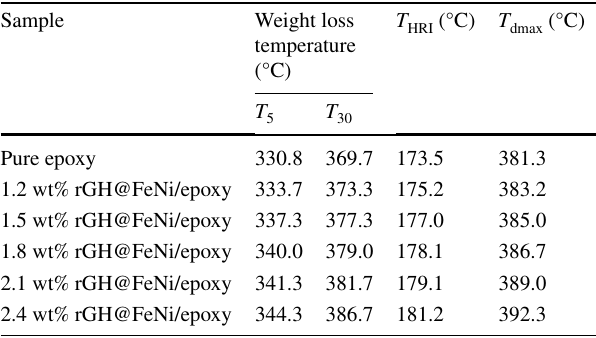
Table 2 Thermal characteristic data of the rGH@FeNi/epoxy com- posites Sample